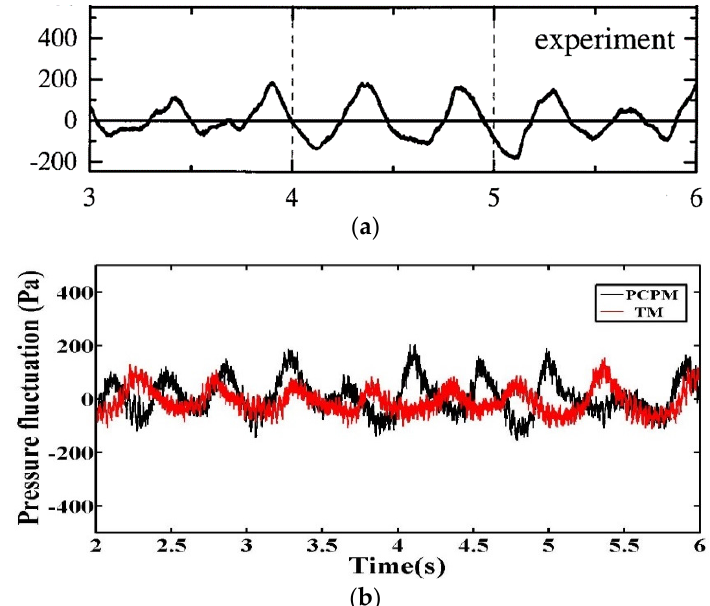
Figure 6. Pressure drop at the 45 mm horizontal section above the fluidized bed distributor. ( a ) experimental result given by Van Wachem et al. [18] (reused with permission from Elsevier); ( b ) simulation results.